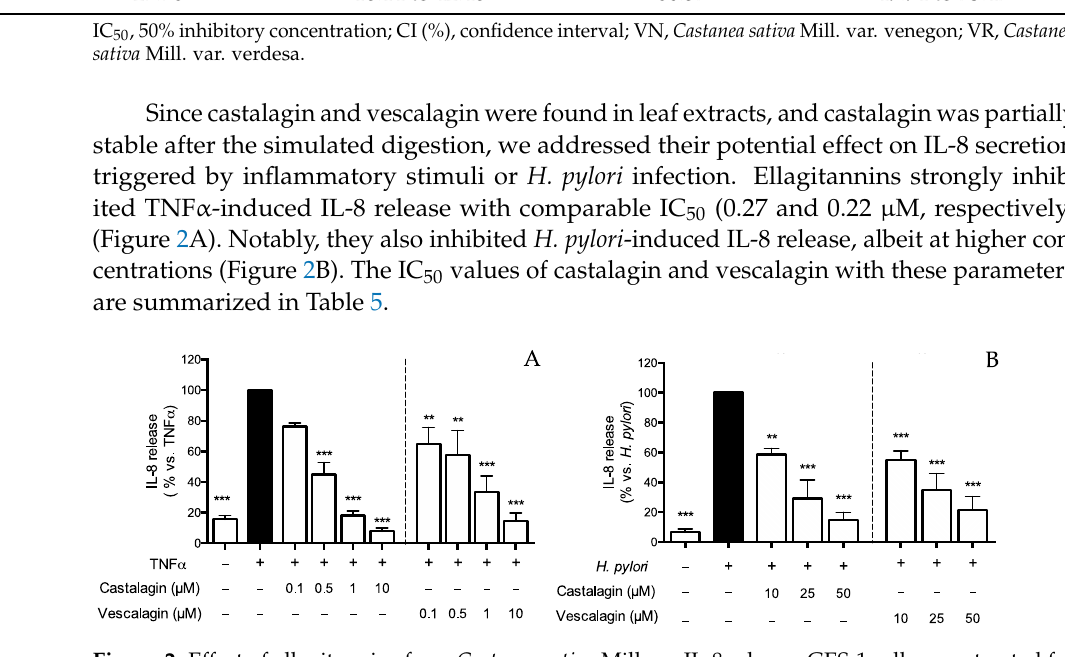
Figure 2. Effect of ellagitannins from Castanea sativa Mill. on IL-8 release. GES-1 cells were treated for 6 h with TNF α (10 ng/mL) ( A ) or H. pylori (ratio 50:1, bacteria:cell) ( B ), in the presence of castalagin or vescalagin. IL-8 was measured by ELISA assay. Results are expressed as the mean ± SEM ( n = 3) of the relative percentage in comparison to stimulus (black bar), to which the value of 100% was arbitrarily assigned. ** p < 0.01, and *** p < 0.001 vs. stimulus. Table 5. IC 50 (µM) of IL-8 release: ellagitannins from Castanea sativa Mill. Ellagitannins vs. TNF